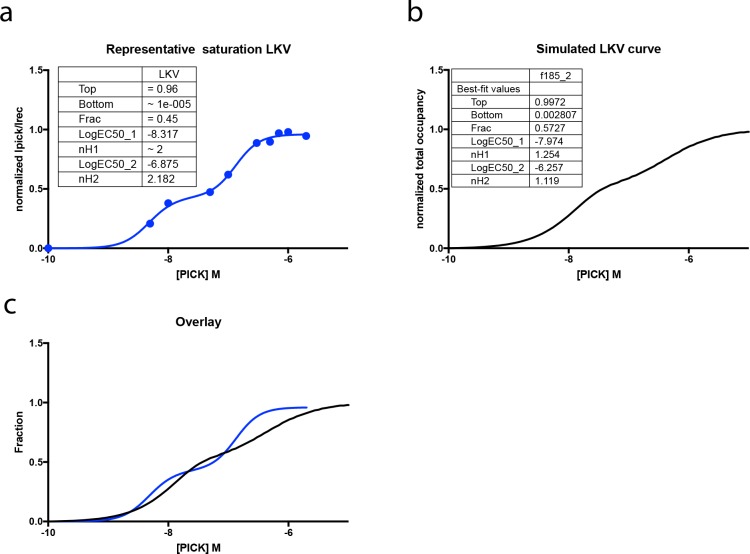
comparison of the PICK WT - LKV binding curves derived from experiments and the simulation.(a) Representative binding curve derived from a single binding experiment of PICK1 WT to LKV. Here the biphasic behavior is not masked by the experimental error between different n’s and the biphasic curve binding becomes more pronounced. (b) Simulated binding curve of PICK1 WT binding to WT from Figure 4. (c) Overlay of the two fits shows good agreement between our experiment and simulation. Simulation parameters are given in the legend of Figure 4 and in the Materials and method section.